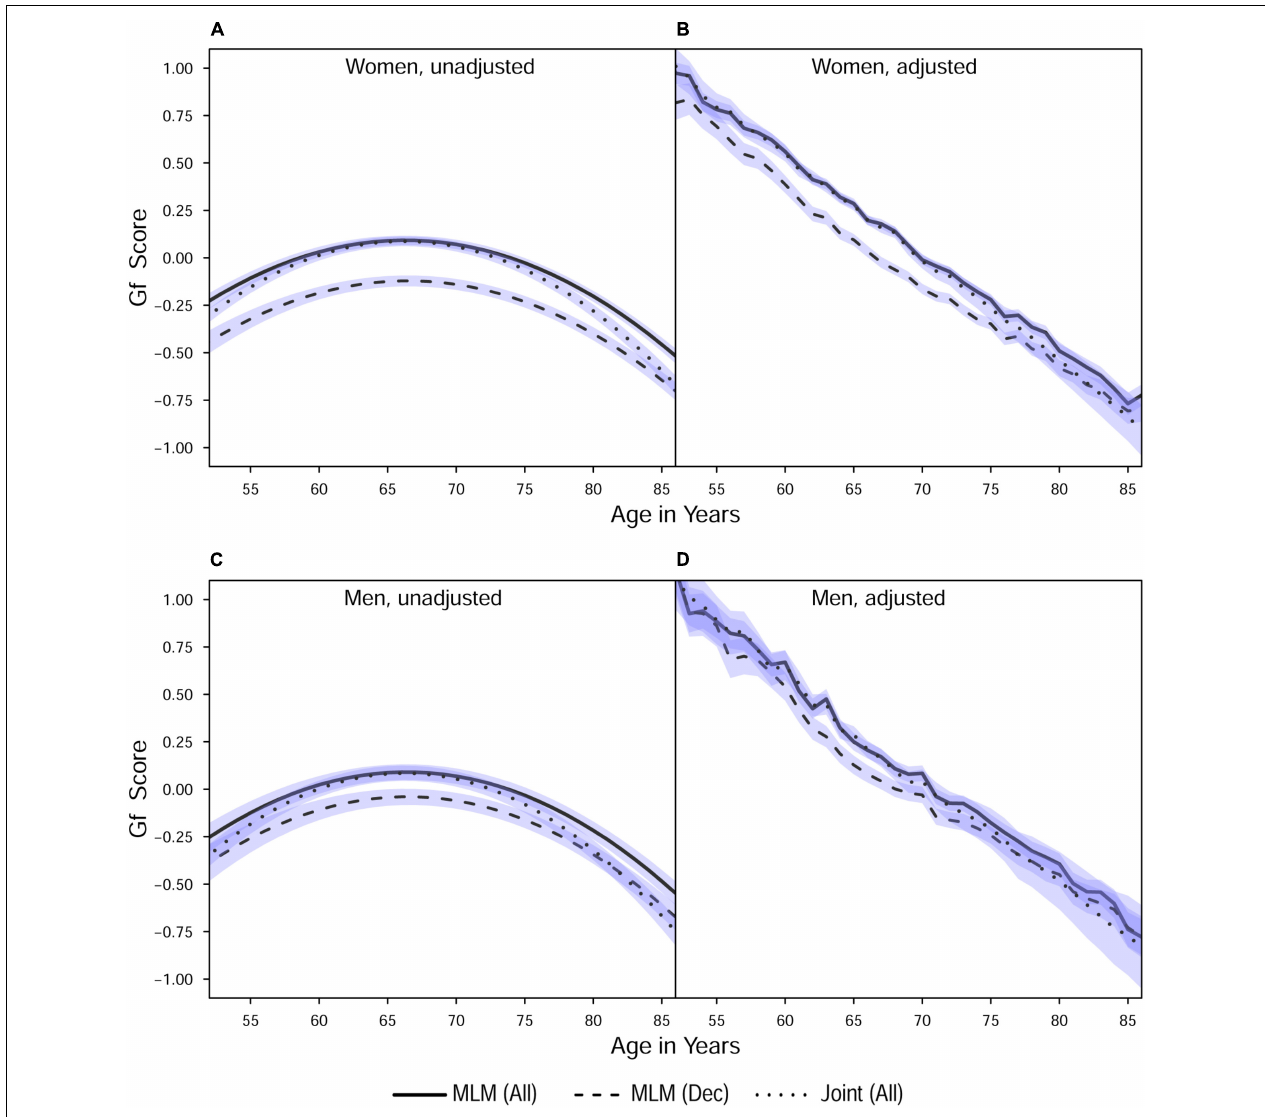
FIGURE 2 | Estimated average changes in fluid intelligence (Z-scaled) by chronological age. (A,C) Trajectories unadjusted for starting age and health-related covariates. (B,D) Trajectories adjusted for differences in starting age, SRH, and tobacco smoking. MLM, standalone, multilevel model trajectories; Joint, joint longitudinal-survival model trajectories; All, data from decedents and survivors; Dec, data only from decedents. Shaded regions indicate 95% credible intervals for the group average